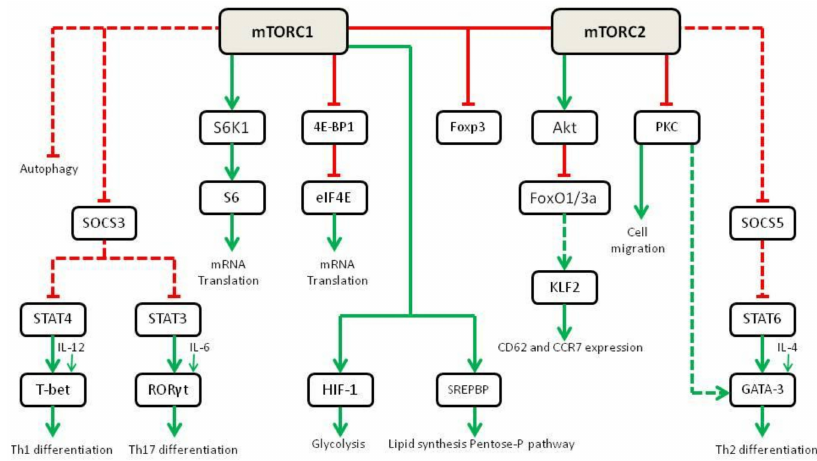
Figure 4. Role of mTOR in cell metabolism and differentiation in immune cells (adapted from [43]). Green lines show activating signals, red lines show inhibitory signals, dashed lines indicate that the exact mechanism is